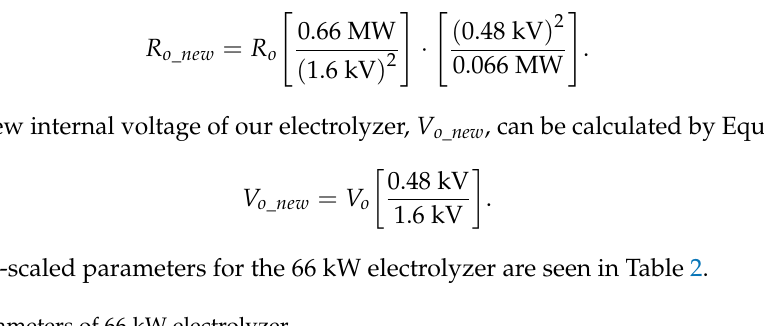
Table 2. Parameters of 66 kW